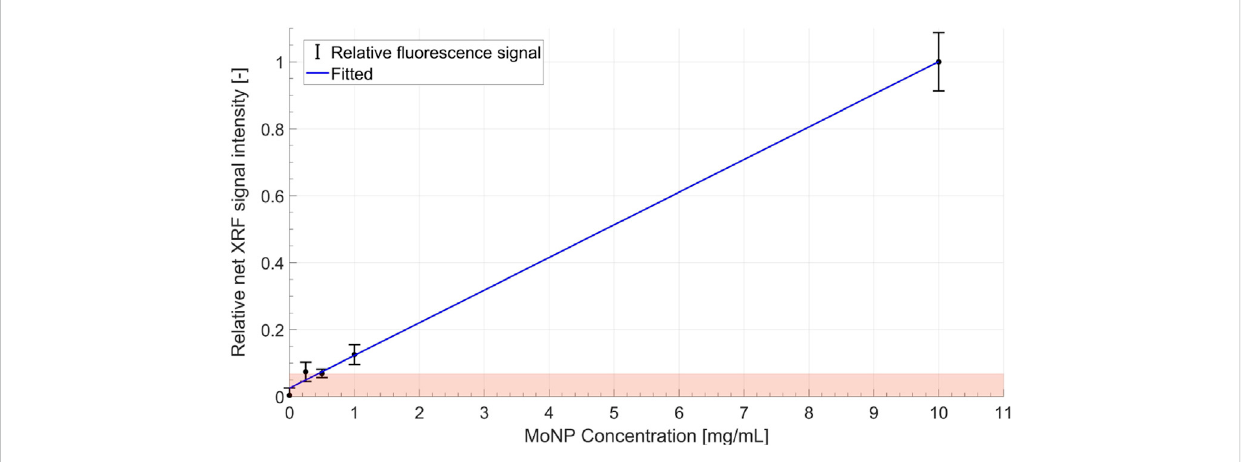
FIGURE 11 Calibration curve showing a linear increase in the relative (normalized by the maximum net XRF signal intensity) net XRF signal intensity with increasingMoNPconcentration.Herearelaxednoiselimitisconsideredduetothelow-countstatisticsinMoNPimaging,i.e.,theboundaryoftheshaded zone represents the 1.96 σ (i.e., ~ 95 % con fi dence interval) background level above the intercept of the calibration curve. The detection sensitivity is de fi ned as the least detectable sample, i.e., 0.5 mg/mL.